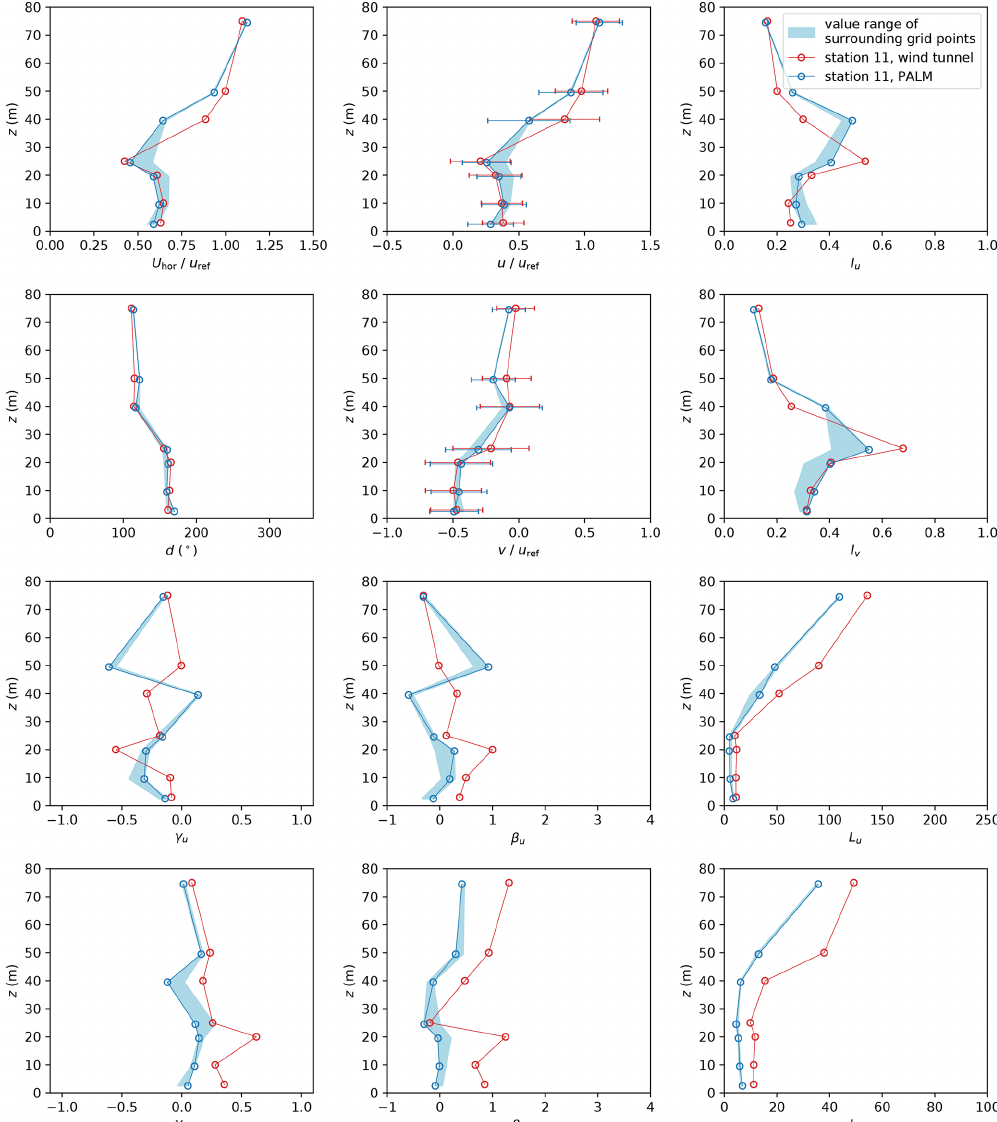
Figure 14. Profiles of mean horizontal wind speed U hor , wind direction d , and wind components u and v as well as turbulence intensity I , skewness γ , excess kurtosis β , and length scale L of both wind velocity components u and v at measurement station 11. Error bars denote the standard deviation of the respective quantity. Note that z = 0 denotes street-level